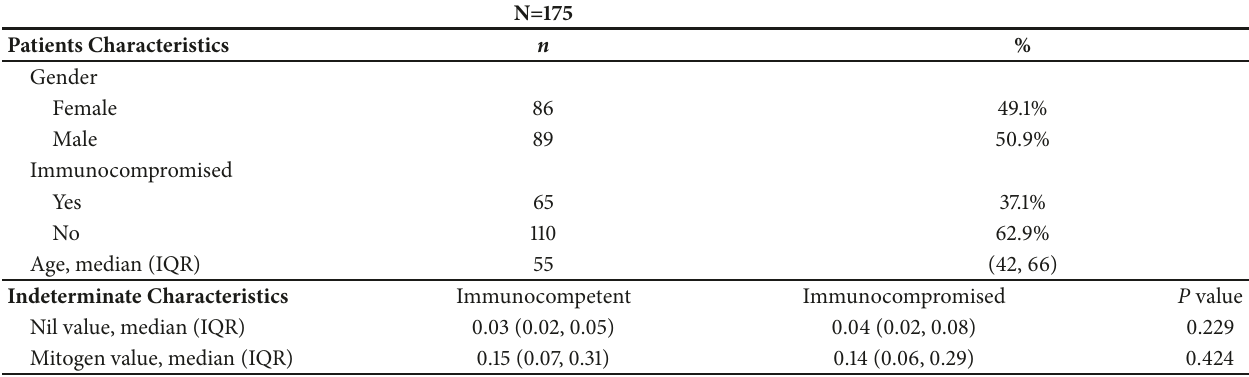
Table 1: Characteristics of patients with indeterminate QFT-G results before education program was implemented.